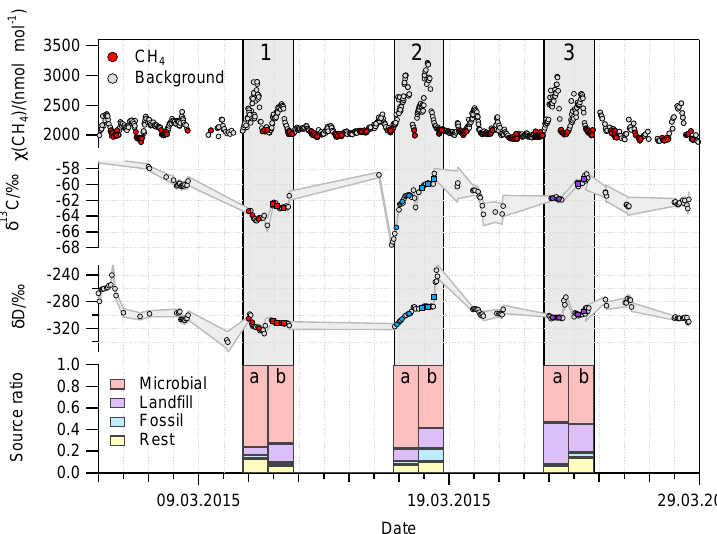
Figure 9. Detailed analysis of three 2-day periods with large CH 4 elevations in March 2015. The top panel exhibits CH 4 mole fraction (grey) with background values in red (10:00–18:00, > 2100nmolmol − 1 ). The middle panels show the mean isotopic signatures ( δ 13 C, δ D) derived with the 12h MKP method. The color-coding in the middle panels (red, light blue, purple) indicates characteristic contributions from different sources; red is microbial, light blue is fossil and purple is waste. For consistency, the same color-coding was chosen in Fig. 7. The bottom graph presents CH 4 source contributions as computed with the FLEXPART-COSMO model using the TNO-MACC inventory, averaged over